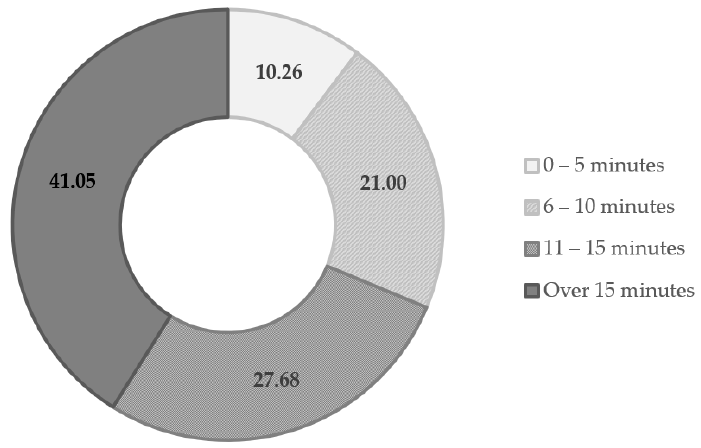
Figure 5. Question: How long would you be willing to walk to your destination?